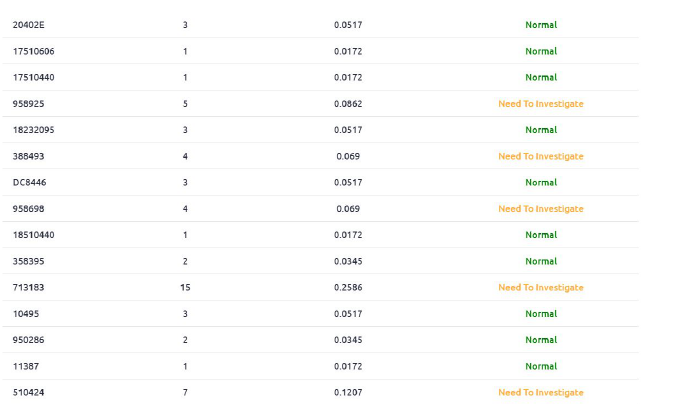
Figure A5. Doctor wrt Patient Rating and status.